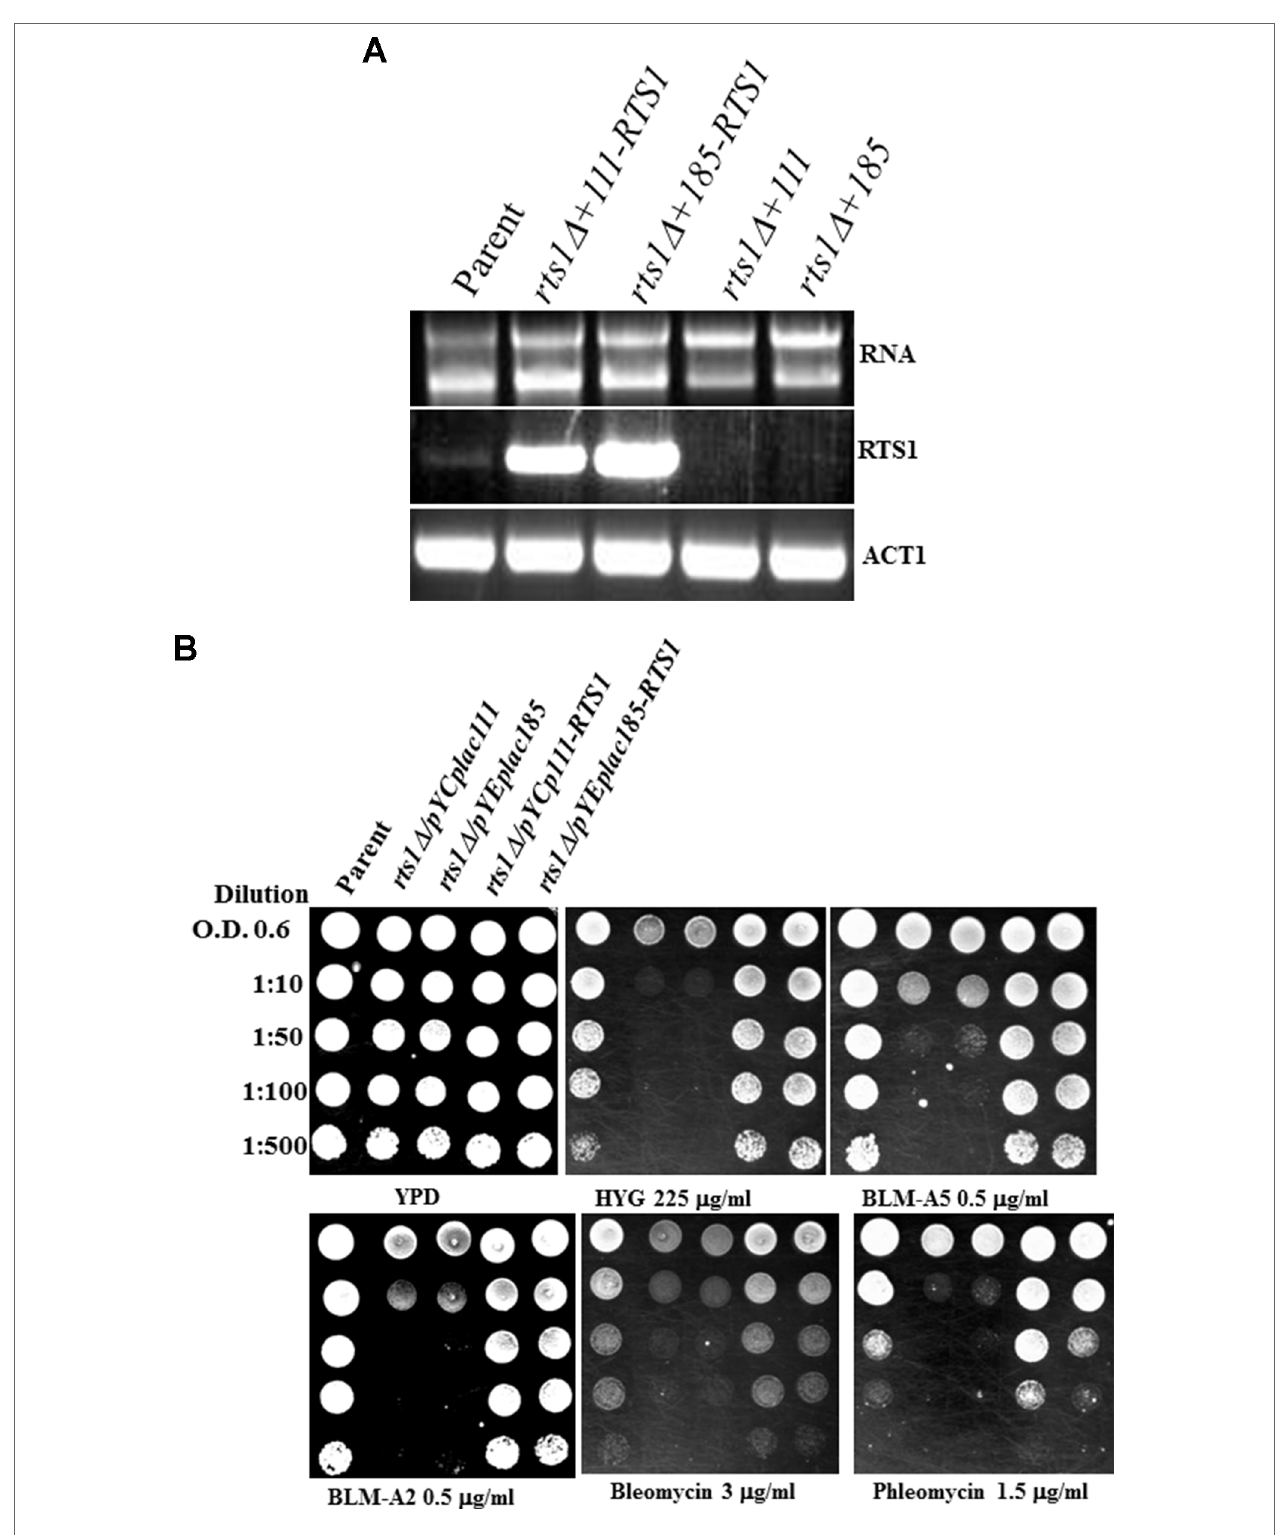
fIGURe 3 | Expression of the RTS1 gene rescues the phenotypes of the rts1Δ mutant. (A) Reverse transcription PCR (RT-PCR) showing expression of the RTS1 gene. The entire RTS1 gene including its promoter was subcloned into the single copy and multicopy vectors YCplac-111 and YEplac-185, respectively and introduced into the rts1Δ mutant. (B) Spot test analysis. The cells were spotted onto the indicated drug plates as in figure 1 . The results are representative of three independent experiments.